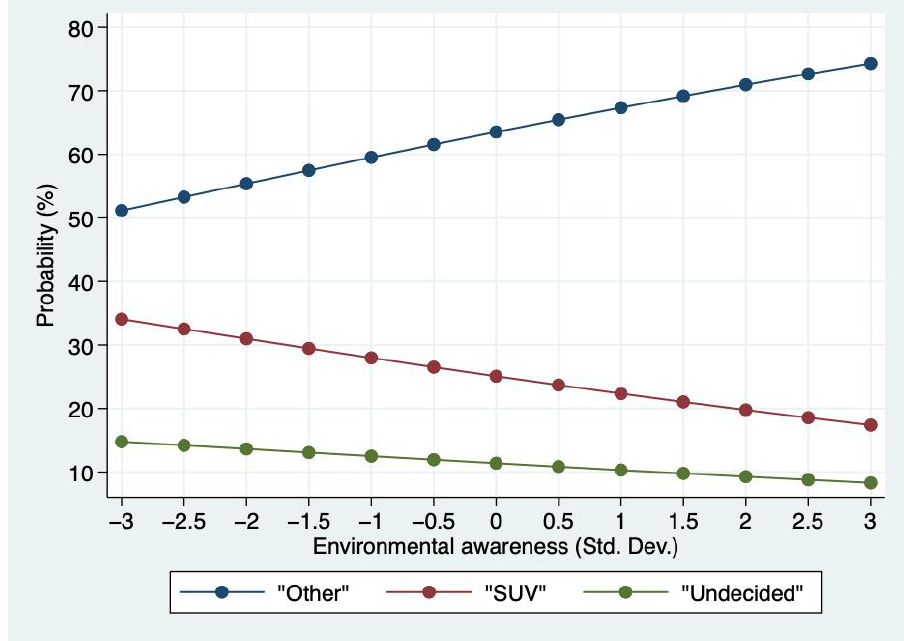
Figure 3. Predictive margins. Environmental awareness.